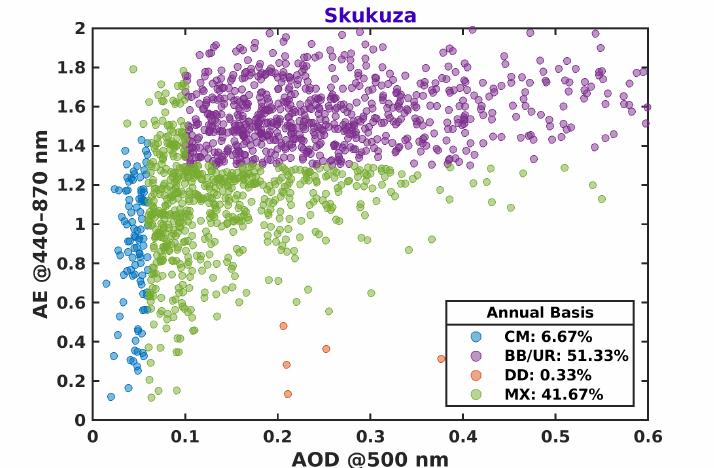
Figure 2. Diagram of aerosol classification at Skukuza (2008–2011 and 2016–2020) defined by us- ing threshold values from Kumar et al. [19]. Each color is associated with an aerosol type: clean marine (CM, in blue), biomass burning/urban industrial (BB/UR, in purple), desert dust (DD, in or- ange), and mixed type (MX, in green). The frequencies of occurrence for each type account for the annual